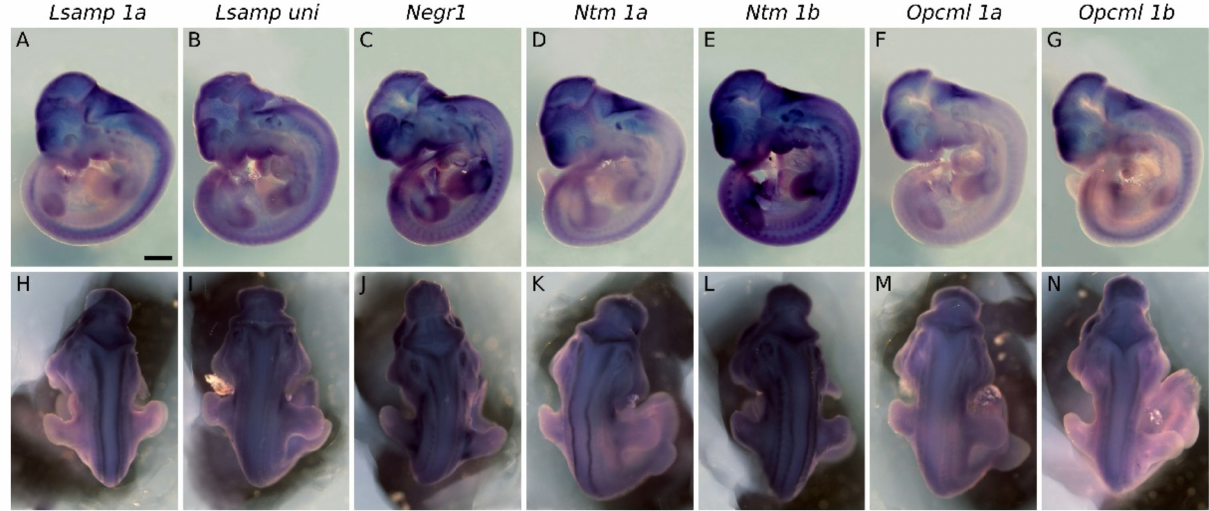
Figure 1. Expression of IgLON family alternative promoters at E11.5. Expression of Lsamp 1a , Lsampuni , Negr1 , Ntm 1a , Ntm 1b , Opcml 1a , and Opcml 1b mRNA was detected by whole-mount in situ hybridization of wild-type embryos. ( A – G ) lateral and ( H – N ) dorsal views of whole-embryos. Observed mRNA expression is seen bilaterally ( H , I , K , L ) along neural tube or ( J , M , N ) at the level of limbs. All observed mRNA probes are expressed in forebrain region and pharyngeal arches. ( A – E ) specific expression of corresponding probes is seen in the developing inner ear. ( A , B , E , G ). Faint expression is seen ( A , B , E , G ) inside and around the developing eye. Scale bar: 1